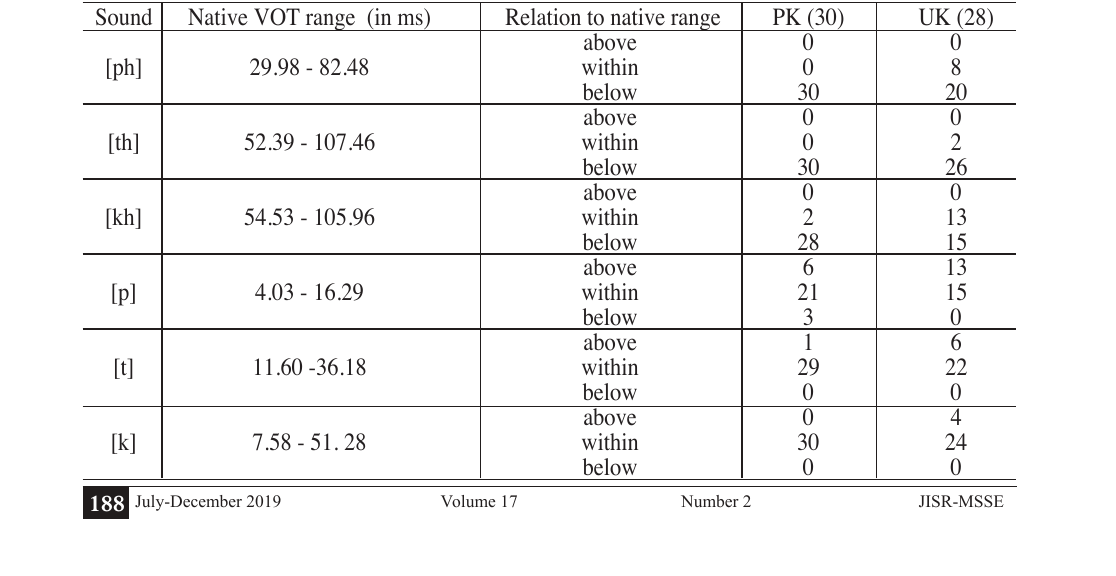
No. of participants within native VOT ranges of English